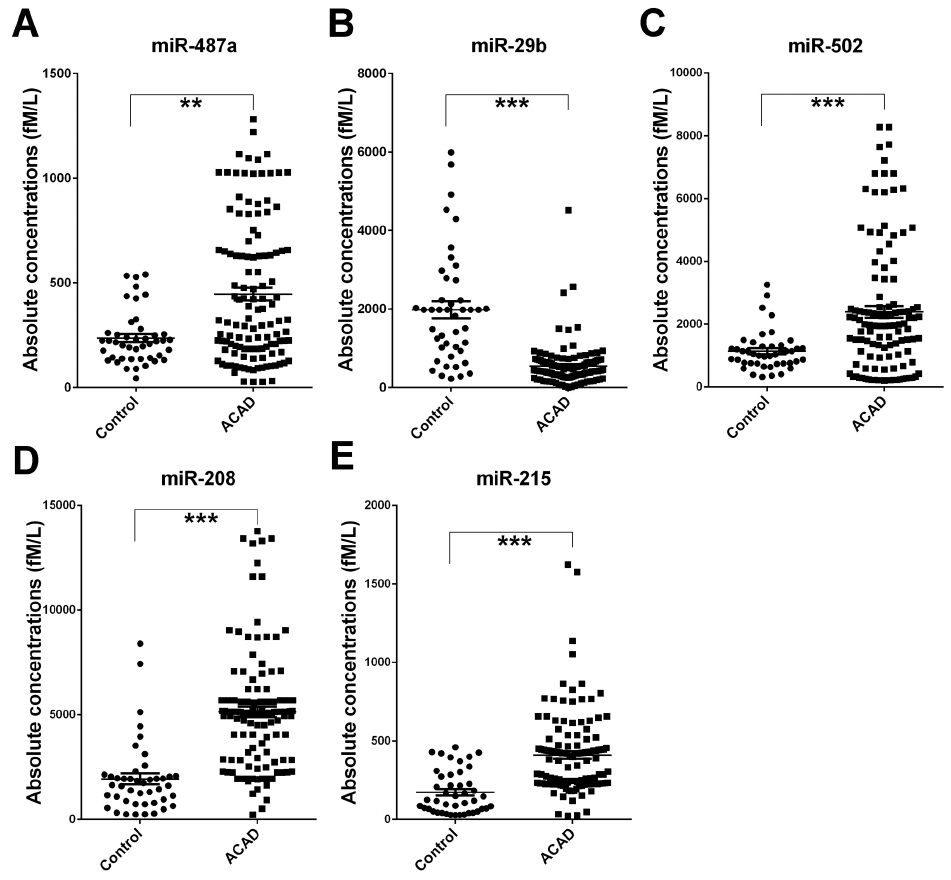
Figure 2. Differential expression of the five miRNAs (A) miR-487a, (B) miR-29b, (C) miR-502, (D) miR-208 and (E) miR-215 in the serum between Atypical Coronary Artery Disease (ACAD) cases and controls. The expression levels of the five miRNAs are detected by RT- qPCR individually. Serum levels of the five miRNAs were measured in 122 AD cases and in 44 controls of training set and validation set using a hydrolysis probe-based RT-qPCR assay. Cq values were converted to absolute values based on the standard curves. Each point represents the mean of triplicate samples. Each p -value was derived from a nonparametric Mann–Whitney U -test. ** p , 0.01; *** p , 0.001.